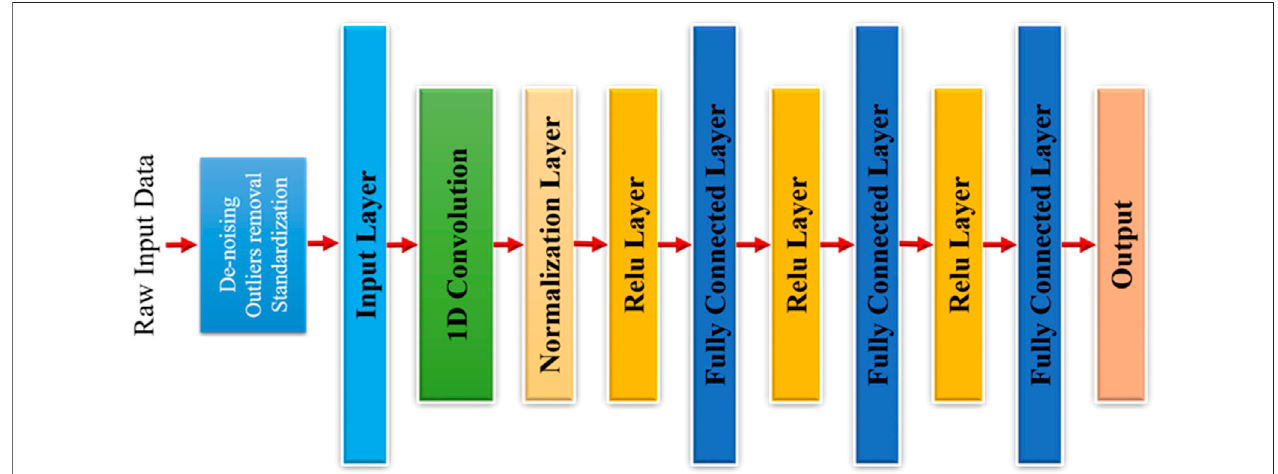
FIGURE 6 | 1D-CNN NOx emission modeling architecture.